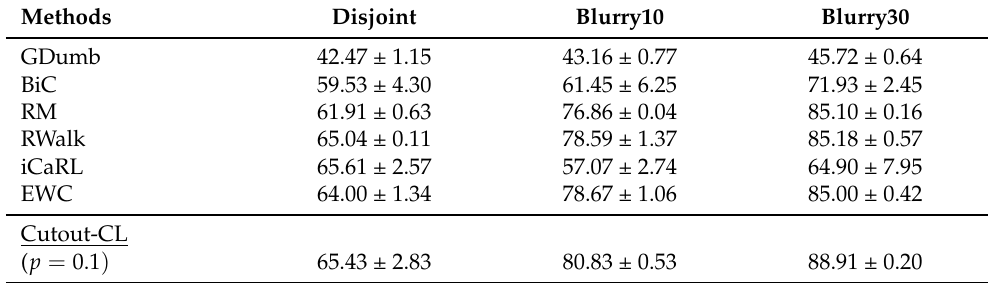
Table 3. ACC 5 of CL algorithms on